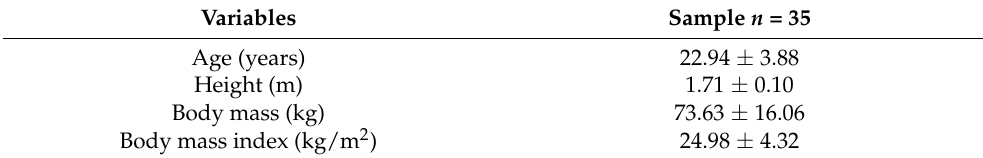
Table 1. Anthropometric characteristics of the sample (mean ±